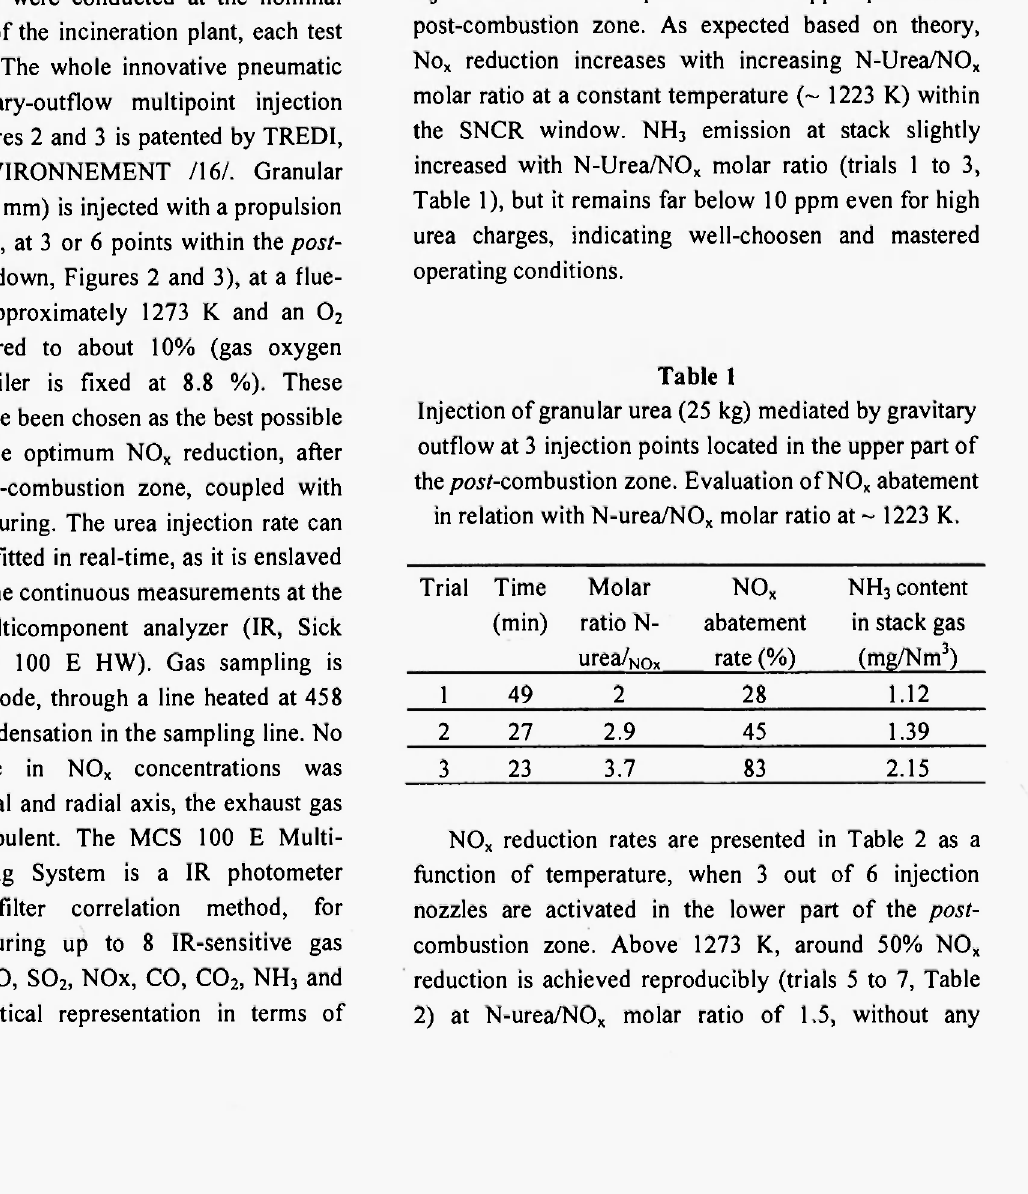
Fig. 3: Details of the three lower injection